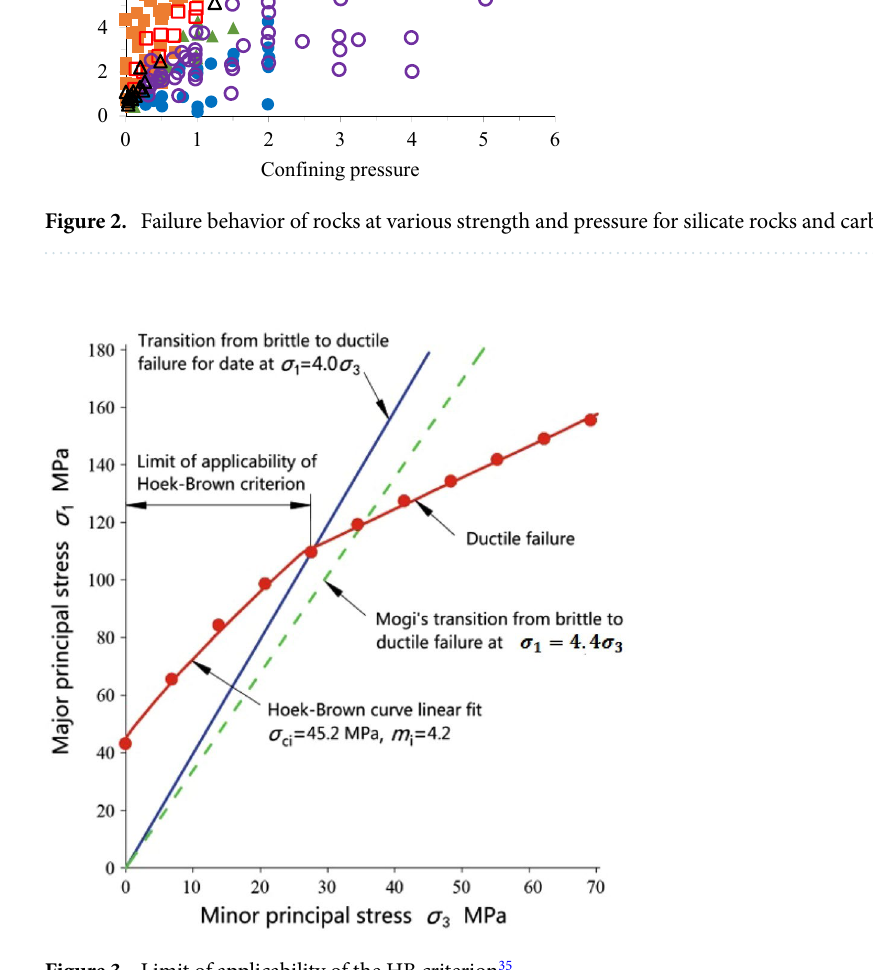
Figure 3. Limit of applicability of the HB criterion 35